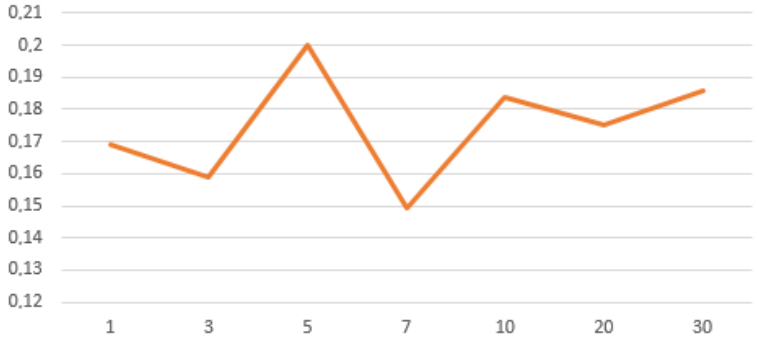
Figure 3. Relative Error (RE) representation for the initial testing phase during various time windows (from 1 to 30 days): time windows ( X -axis) and the obtained RE values ( Y -axis).